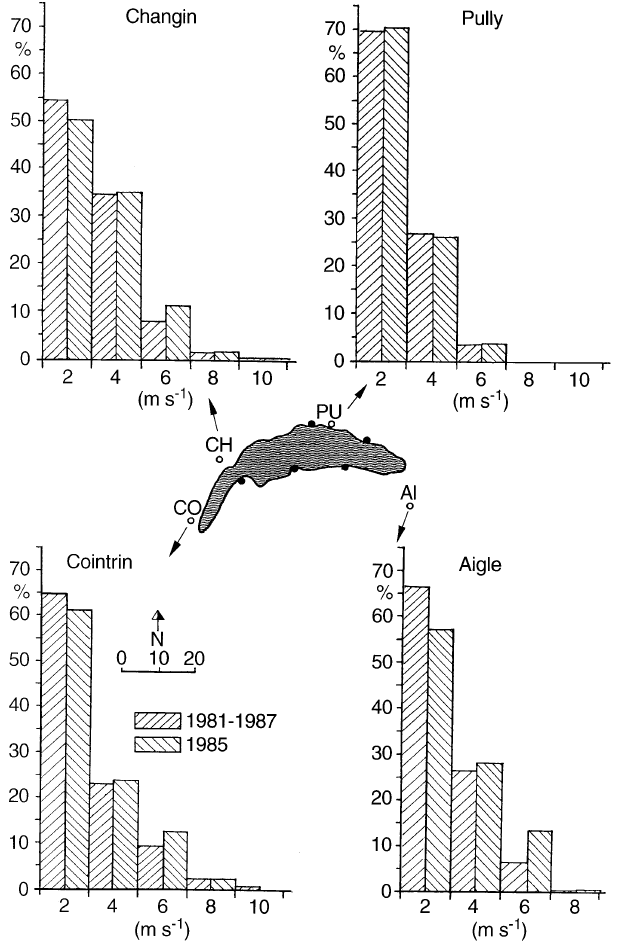
Fig. 3. Histograms of wind speeds at the four stations CO, CH, PU and AI for the summer period from May to September. The informa- tion extracted from the full record 1981 to 1987 as well as from the summer of 1985 only are shown